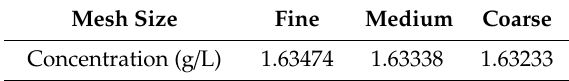
Table 3. Final concentration of biomass in the last step of solving equations in three computational